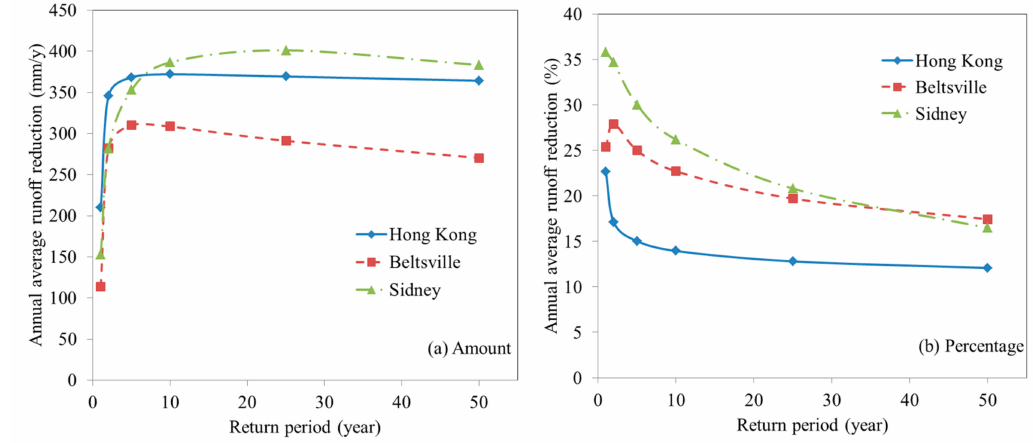
Figure 5. Annual average runo ff reduction during storms with di ff erent return periods, given in terms of ( a ) amount and ( b )